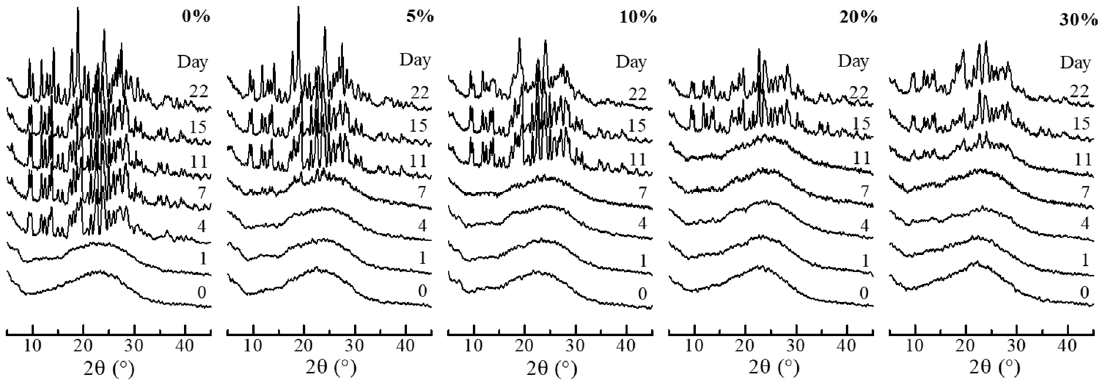
Figure 5. XRD patterns of SGR granules after storage at 20 °C/75% RH. Percentages indicate the weight percentage of PVP-VA in the granules.